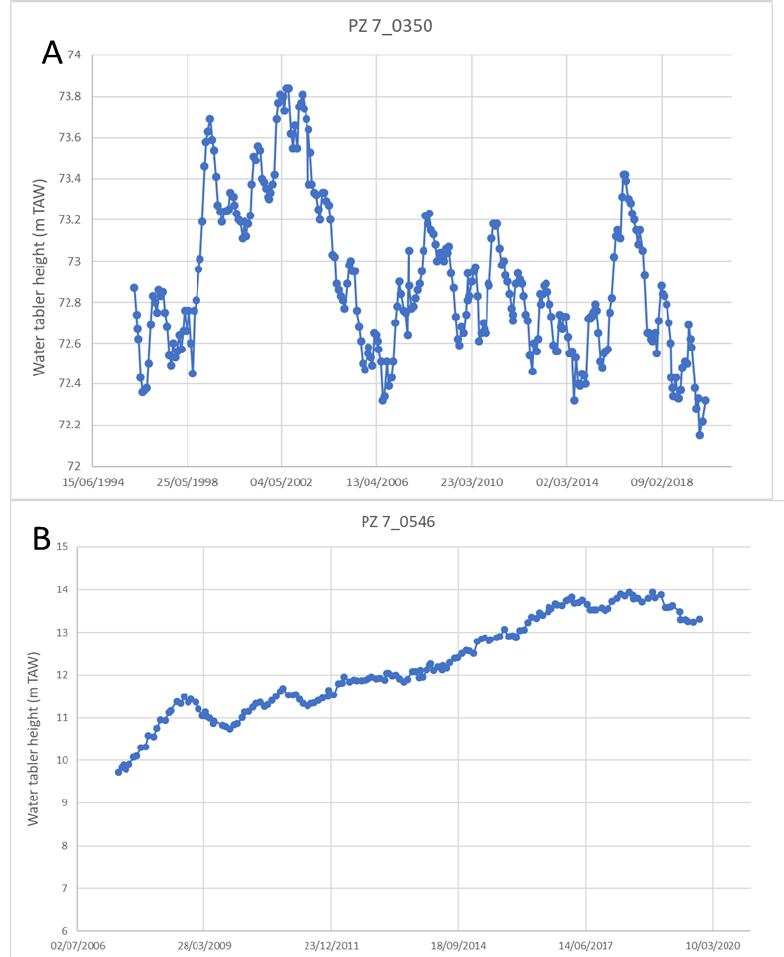
Figure 12. Evolution of the water table in the ( A ) Sand of Bolderberg (HCOV 253) and ( B ) Cretaceous calcarenite (HCOV 1100). The heights are in m TAW, which stands for Tweede Algemene Waterpassing (Belgian orthometric second general leveling).